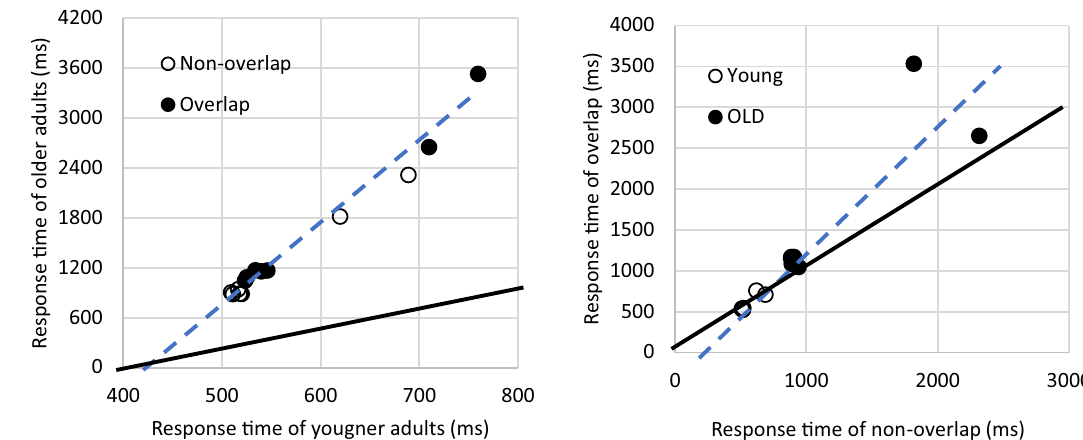
Figure 6. The Brinley plot ( A ) and state traces ( B ) of the three experiments. Each dot represents one experimental condition in experiments 1–3. The black line illustrates the diagonal of the plot, and the blue dashed line is the fitted linear